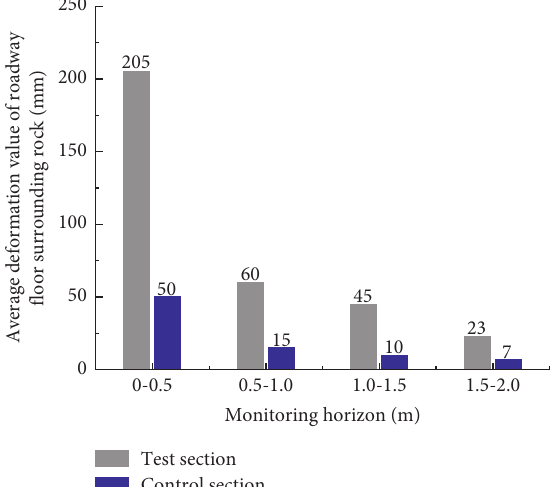
Figure 14: Histogram of average deformation value of roadway floor surrounding rocks in different layers.